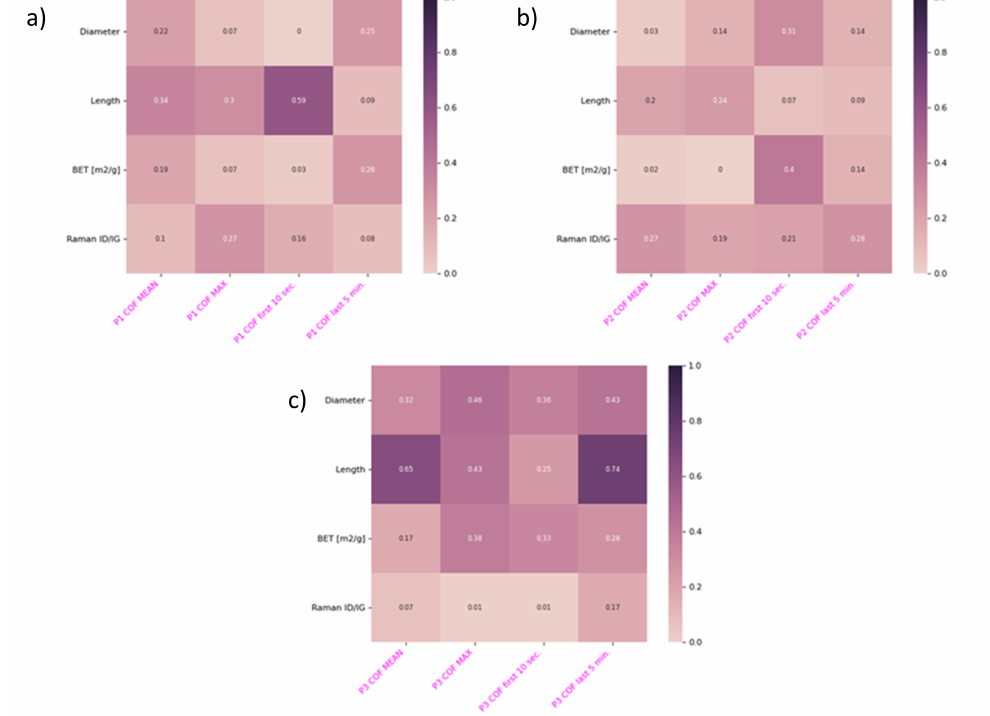
Figure 8. Correlation matrix for CNT diameter and length, BET surface, ID/IG ratio calculated for the CNTs’ Raman spectra, and COF reduction (tribometer) for all analysed plastics: polyethylene ( a ), POM-C ( b ), and polyamide PA6 ( c